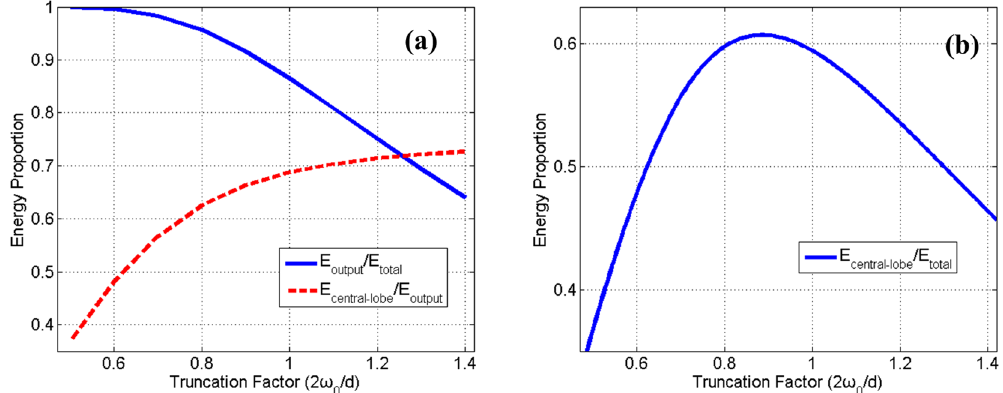
Figure 2. The energy proportion as the function of truncation factor.